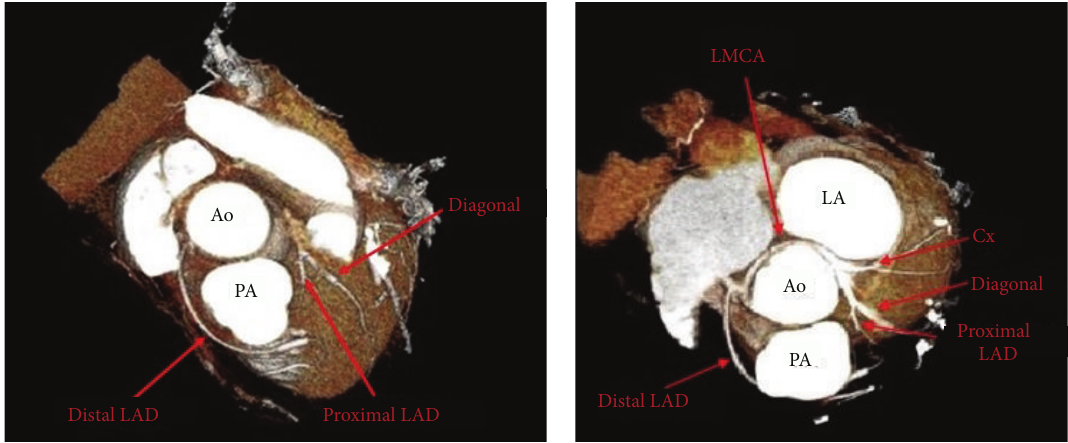
Figure 2: Colored three-dimensional (3D) volume rendered CT angiography images showing single coronary artery (SCA) arising as a common trunk from the right sinus of Valsalva and bifurcating into the right coronary artery (RCA) and the left main coronary artery (LMCA). RCA gives rise also to distal LAD which courses anterior to the PA on its way to the left ventricle. LMCA crosses the base of the heart turning posteriorly behind the aorta dividing into proximal left anterior descending artery (LAD) and circumflex artery. Left atrium (LA), aorta (Ao), and pulmonary artery